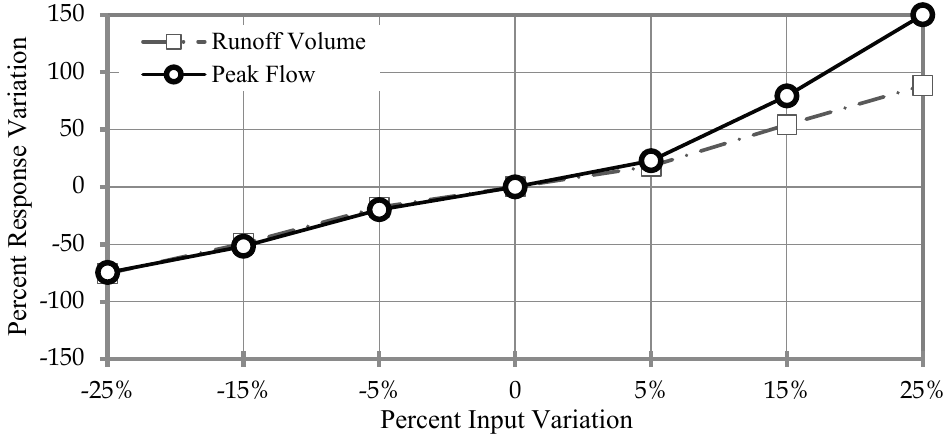
Figure 6. Sensitivity of SCS curve number to runoff amount and peak flow rate.